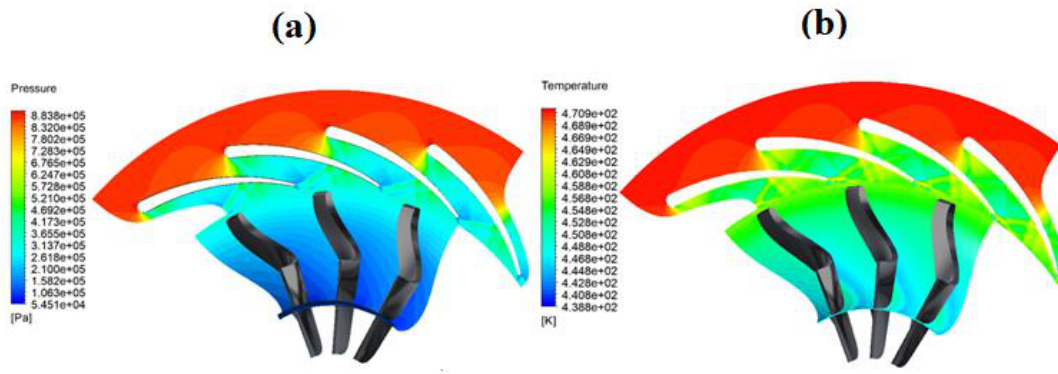
Figure 18. Pressure ( a ) and temperature ( b ) distributions at design point (N = 40,000 rpm, PR = 6.9).